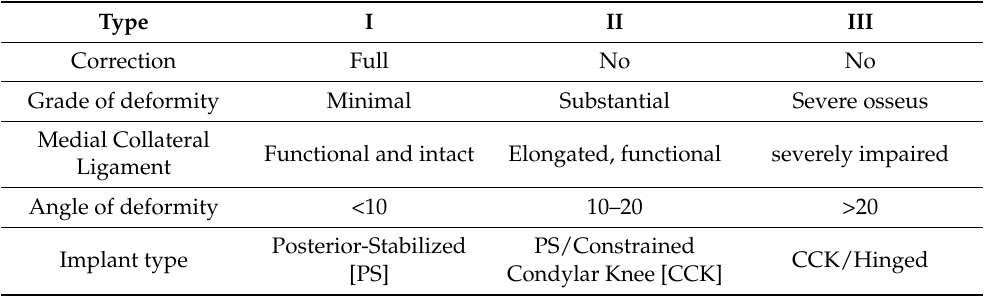
Table 1. Ranawat’s classification of the valgus